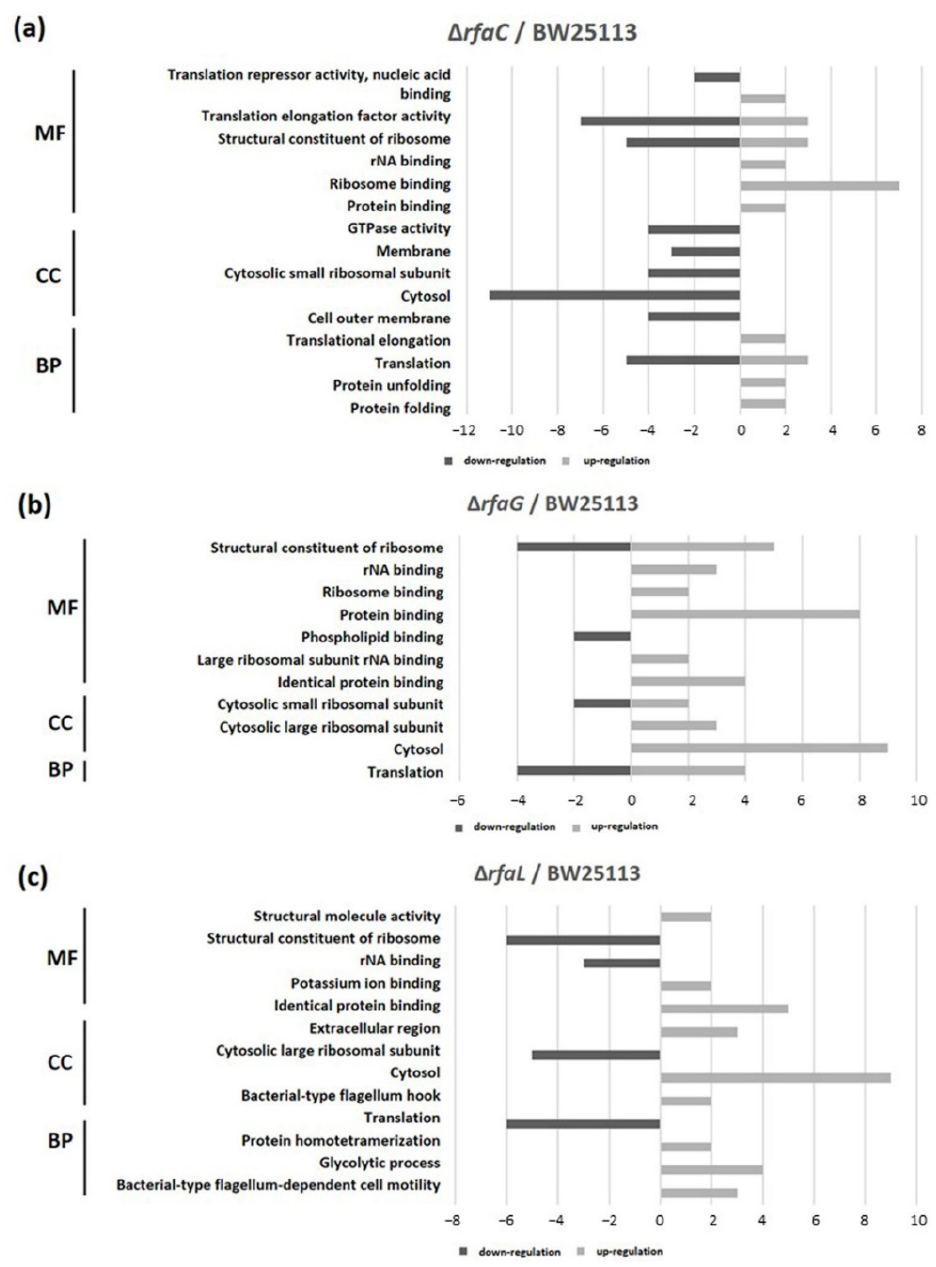
Figure 6. Functional classification of OMV proteins. Gene ontology (GO) classification was conducted to determine protein content. ( a ) E. coli BW25113 ∆ rfaC strain and E. coli BW25113 shared clusters. ( b ) E. coli BW25113 ∆ rfaG strain and E. coli BW25113 shared clusters. ( c ) E. coli BW25113 ∆ rfaL strain and E. coli BW25113 shared clusters. MF: Molecular Function; CC: Cellular Component; BP: Biological Process.